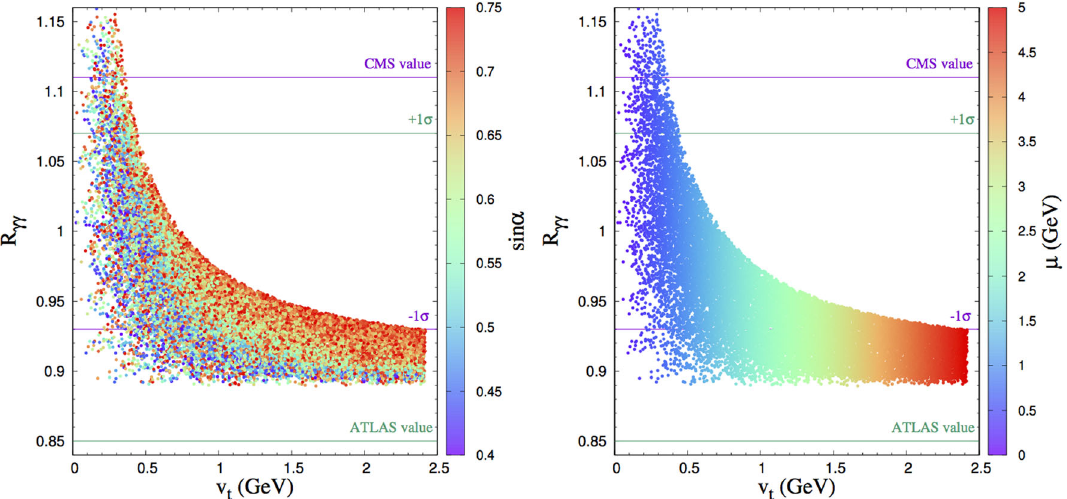
Fig. 11 Left: Scatter plot for sin α in the plan ( R γγ ,v t ) with 10 − 3 ≤ μ ≤ 5 (GeV). Right: R γγ as function of v t , where the palette shows the size of